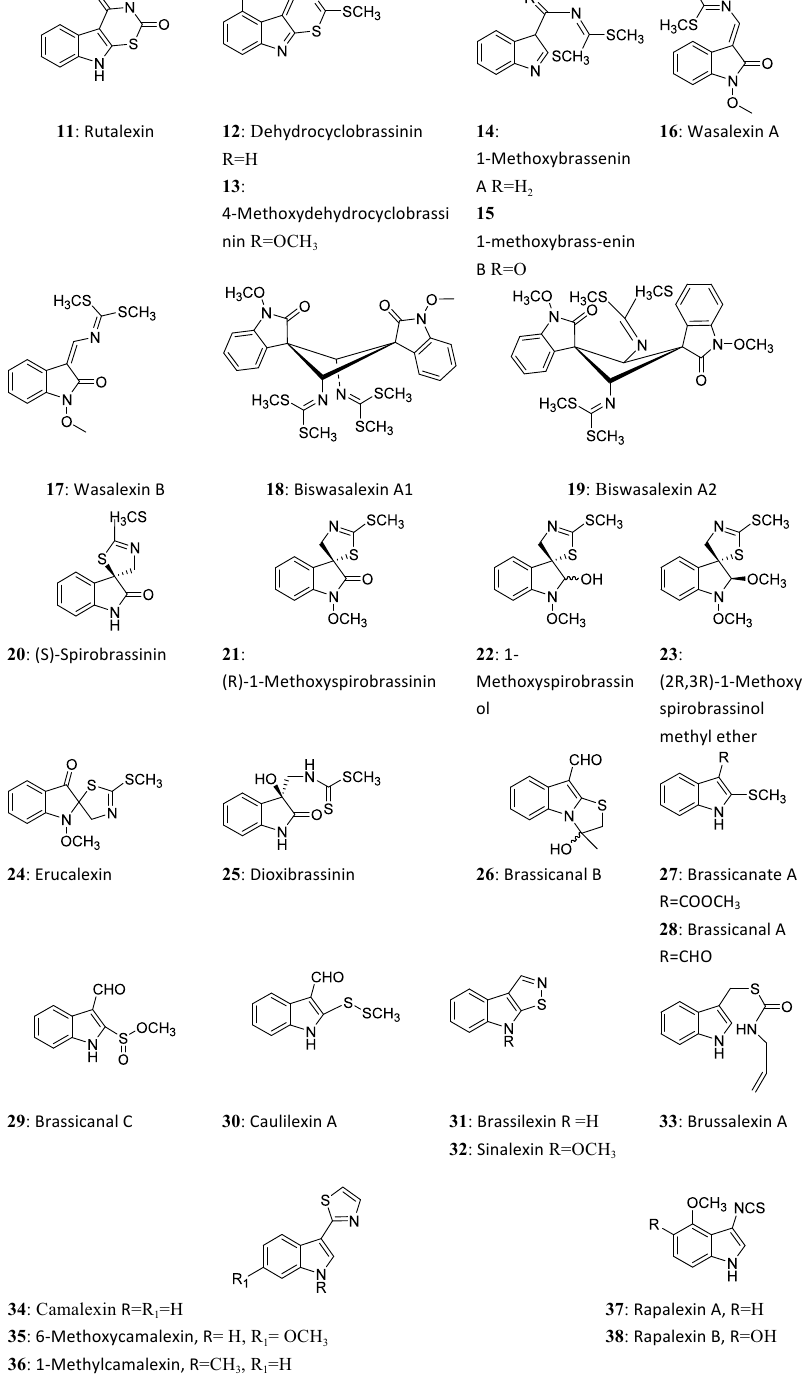
Fig. 4: Structures of sulfur-containing phytoalexins ( 11 - 38 ) Fig. 4. Structures of sulfur-containing phytoalexins ( 11 – 38 ) 2 Sinigrin ( 48 ) is hydrolyzed by myrosinase upon mechanical in- enhance the biosynthesis of glucosinolates including sinigrin ( 48 ) juries of the plant tissue, which produces compounds named allyl as well as isothiocyanates. In a recent study, g eilfuS et al. isothiocyanate, ally thiocyanate, allyl cyanide, and 1-cyano-2,3-epi- thiopropane ( g erendáS et al., 2009; S AlAdino et al., 2016). The biosynthesis of glucosinolates can be manipulated by several envi- ronmental stress factors including light, nutrients, fungal infection, wounding, and insect damage ( g erendáS et al., 2008b; r AdoJcic r edovnikovic et al., 2008). For instance, k iM et al. (2018) indicated that kale grown under treatments with NaCl, Na 2 SeO 3 , or both would